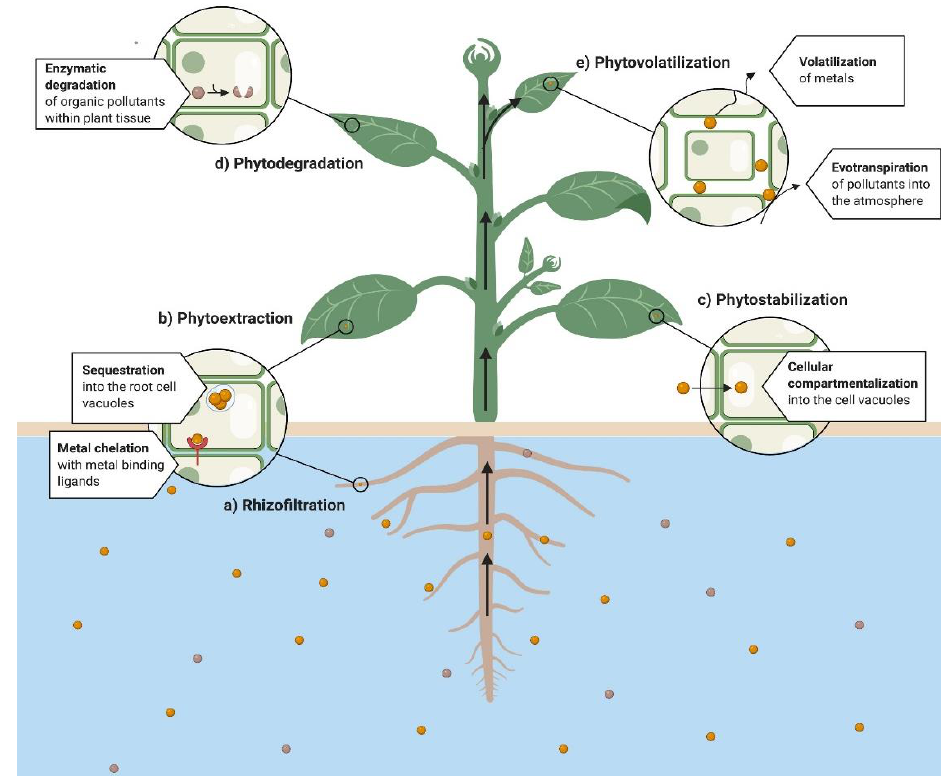
Figure 2. General diagram of phytoremediation processes in water.